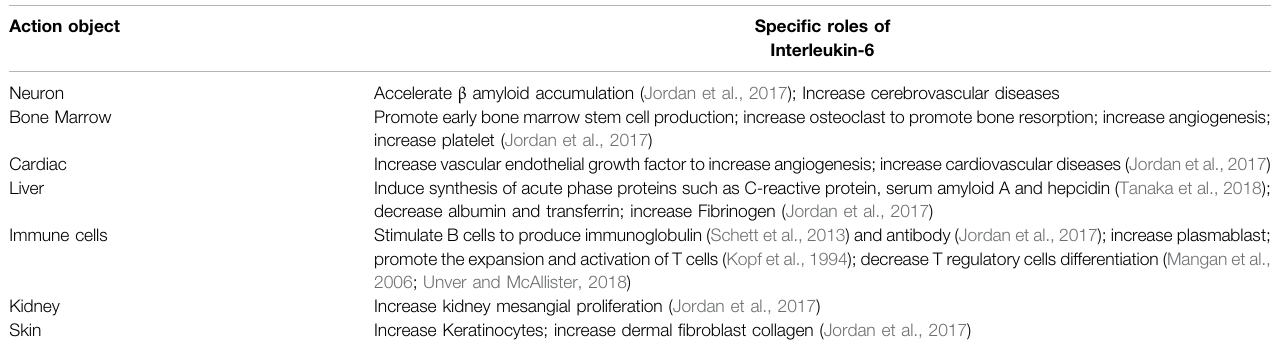
TABLE 1 | Function of